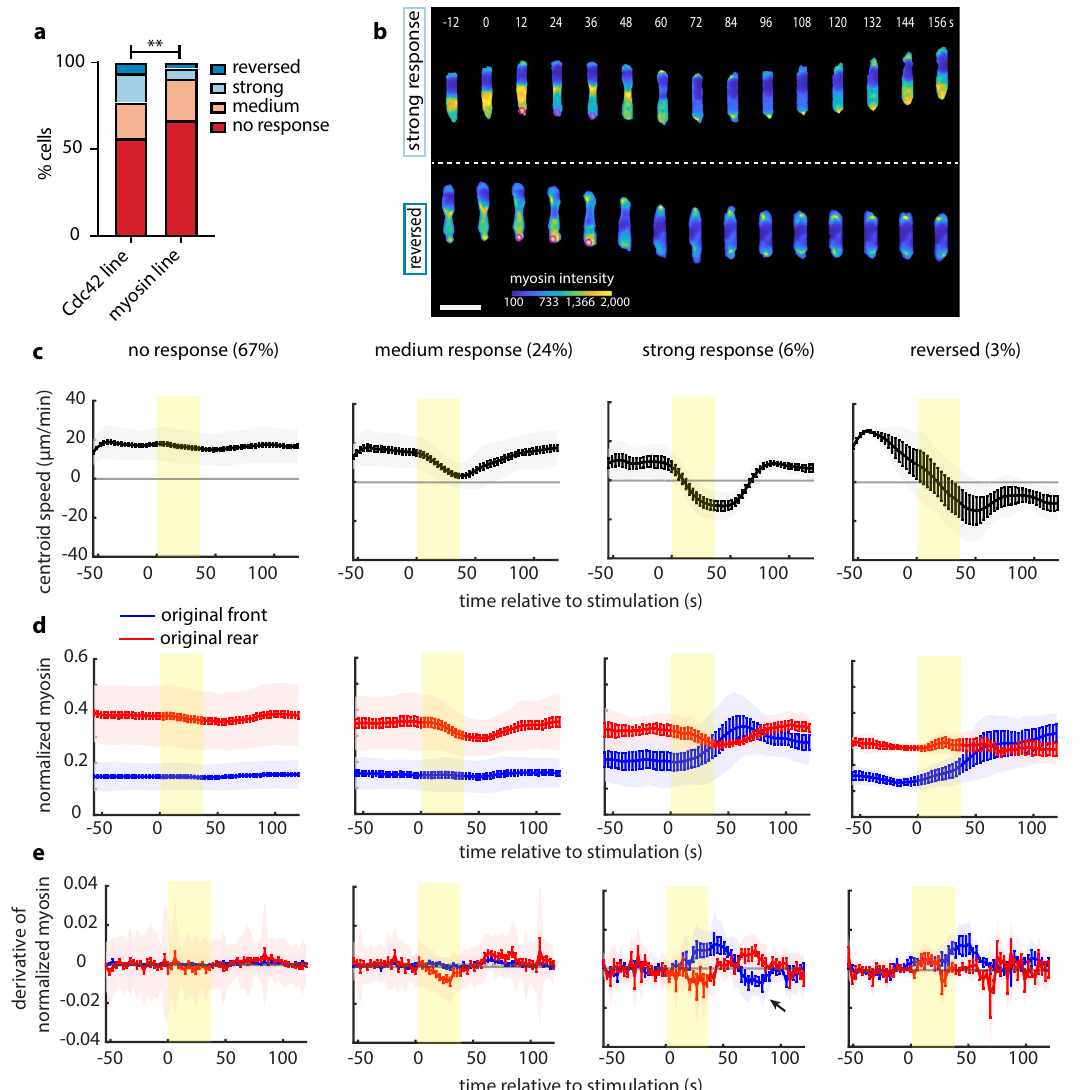
Fig. 6 Myosin II suppresses cellular reorientation and lags behind Cdc42 activity response. a Stacked bar plots of the percentage of cells exposed to transient stimulation that showed no response, medium response, strong response, and reversed for n = 261 cells of the Cdc42 line and n = 147 cells of the myosin line (from 20 and 8 independent experiments, respectively); p -value of two-sided Fisher ’ s exact test (** p < 0.01, exact p -value is provided in Source Data fi le). b Representative live-cell imaging snapshots of stimulation experiments with cells expressing parapinopsin and a myosin light chain sensor/ cytosolic tag, showing a strong response (upper panel) and a reversed response (lower panel). Cells migrated unperturbed for 60 s prior to starting a transient 12-pulse stimulation at their cell rear (magenta circles). Myosin intensity pseudo-colored to facilitate visualization. Images were captured every 3 s and subsampled for illustration purposes. Scale bar: 25 μ m. c – e Mean cell centroid speed ( c ), normalized magnitude ( d ), and normalized derivative ( e ) of myosin intensity at the original front (blue) and rear (red) over time for each cellular response (lines: means, shaded regions: SD, error bars: mean value ± SE). Data are averages from n = 98 non-responders, n = 35 medium responders, n = 9 strong responders, and n = 5 reversers. Rectangular yellow shaded region represents the start and stop of the pulsated stimulation. Source data are provided as a Source Data fi